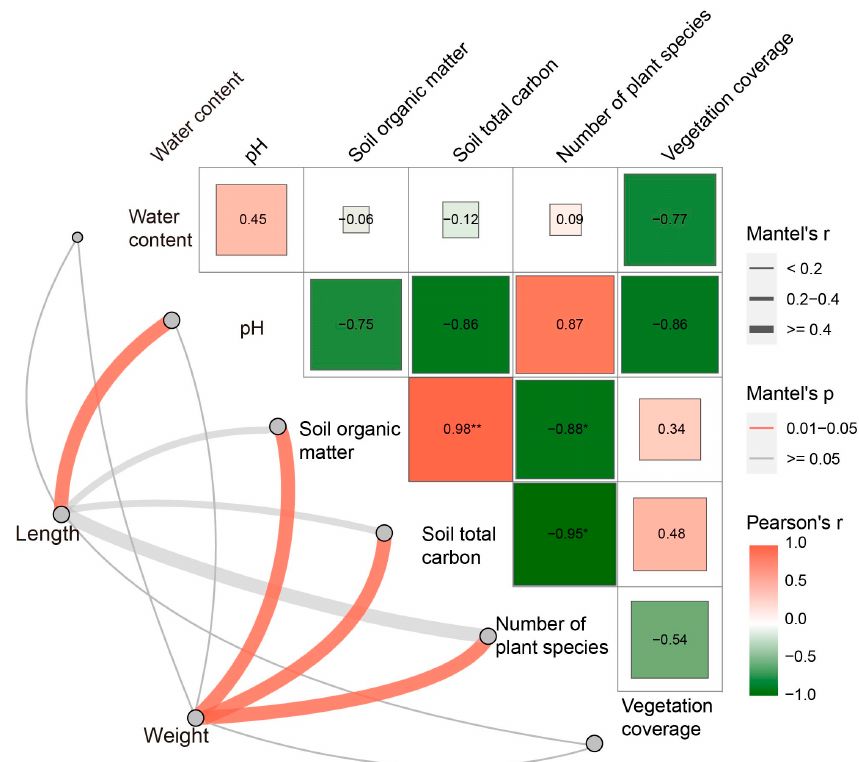
Figure 6. Correlation of habitat environmental factors with physical characteristics of pill bugs (Edge widths indicate Mantel’s r statistics corresponding to distance correlations, and edge colors indicate statistical significance based on 9999 permutations showing pairwise comparisons of physical characteristics with environmental factors. The color gradient in the box indicates Pearson’s correlation coefficient, the magnitude of which is proportional to the r-value, and the number indicates Pearson’s r-value. The “*” means p < 0.050; The “**” means p < 0.01 for Pearson correlation.)